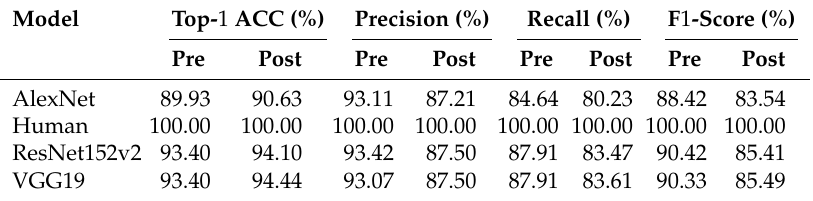
Table 8. Metrics of ASIA human subjects and the selected deep neural networks AlexNet [55], VGG19 [56], and ResNet152v2 [57] on the pre-CRT (original) and post-CRT (changed) ILSVRC2012 subset D (cid:48)